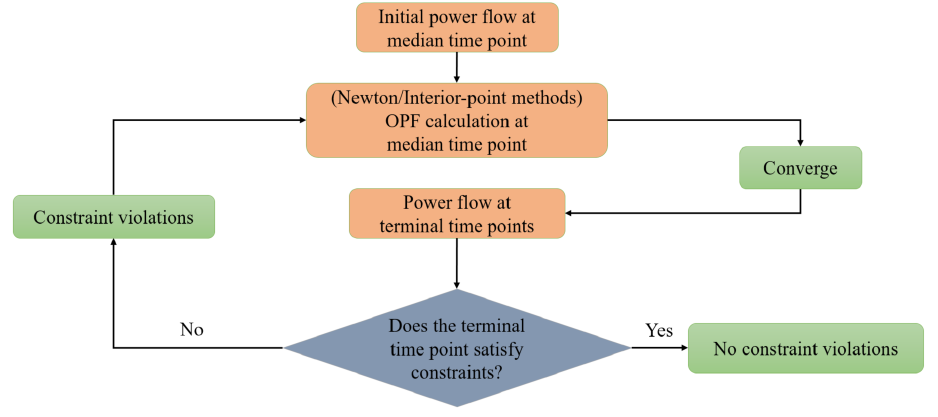
Figure 4. Interval optimal power flow